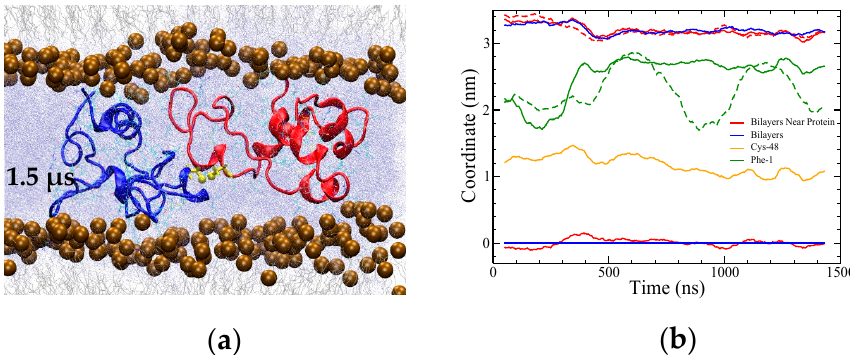
Figure 9. ( a ) Snapshot of the final CO2 system after 1.5 µ s of molecular dynamics. The snapshot shows a 7 nm portion of the 11 nm width of the simulation box. ( b ) The distance (difference in z coordinates) between the bilayers reduced only very slightly over the course of the simulation. Maximum density positions of phosphorous atoms from lipid headgroups in the bilayers overall (blue) and within 0.5 nm of lateral distance from the protein (red) are plotted, illustrating bilayer separation. All coordinates are in reference to the overall lower leaflet position. The dashed red line corresponds to the difference between the red lines. Green lines show the position of F1, solid for the red subunit and dashed for the blue, as an indicator of the position of the residue 1–7 insertion sequence. The data are running averages over 50 points.